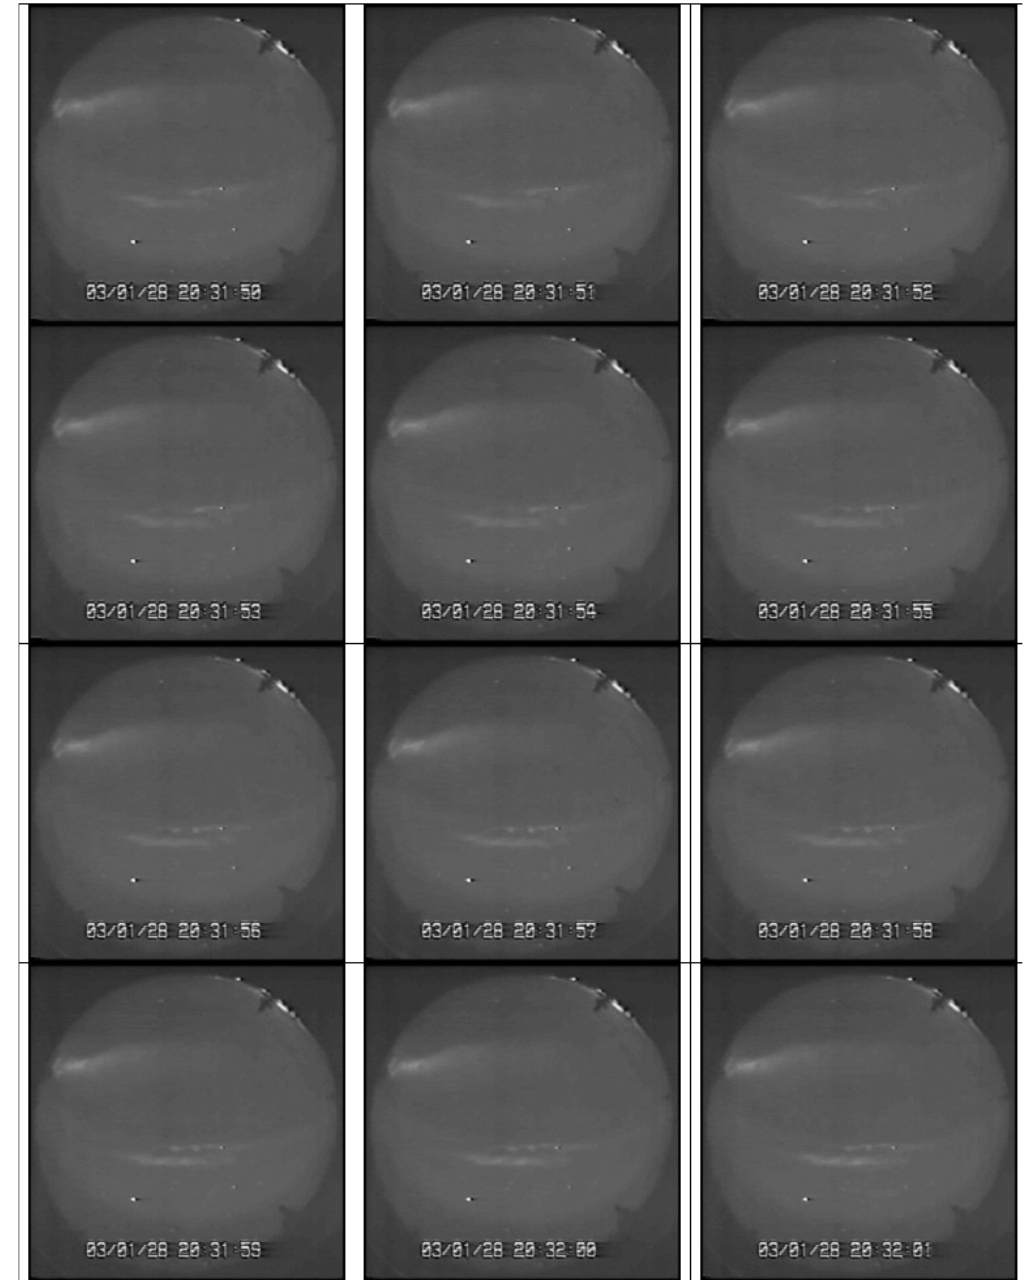
Fig. 4. Auroral imagers for the event 28 January